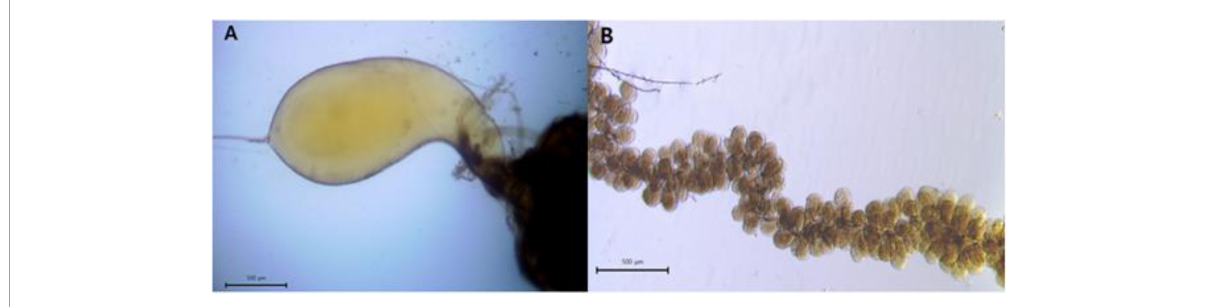
FIGURE2 (A) Venom gland sac on day 18 and (B) hypopharyngeal gland acini on day 5 of caged honey bees fed with